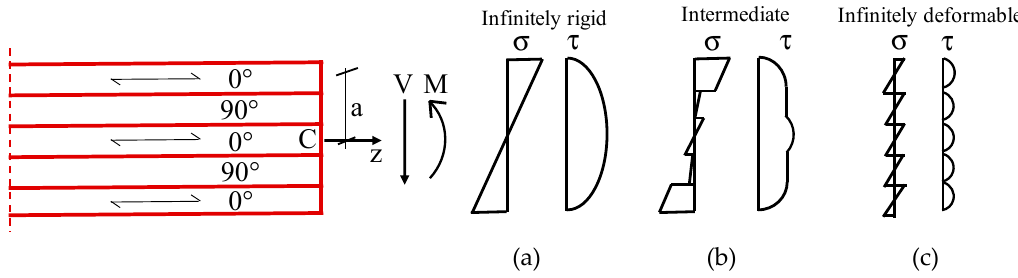
Figure 3. Normal ( σ ) and tangential ( τ ) stress distribution in CLT panels: ( a ) infinitely rigid transverse layers, ( b ) intermediate deformable transverse layers, and ( c ) infinitely deformable transverse layers.